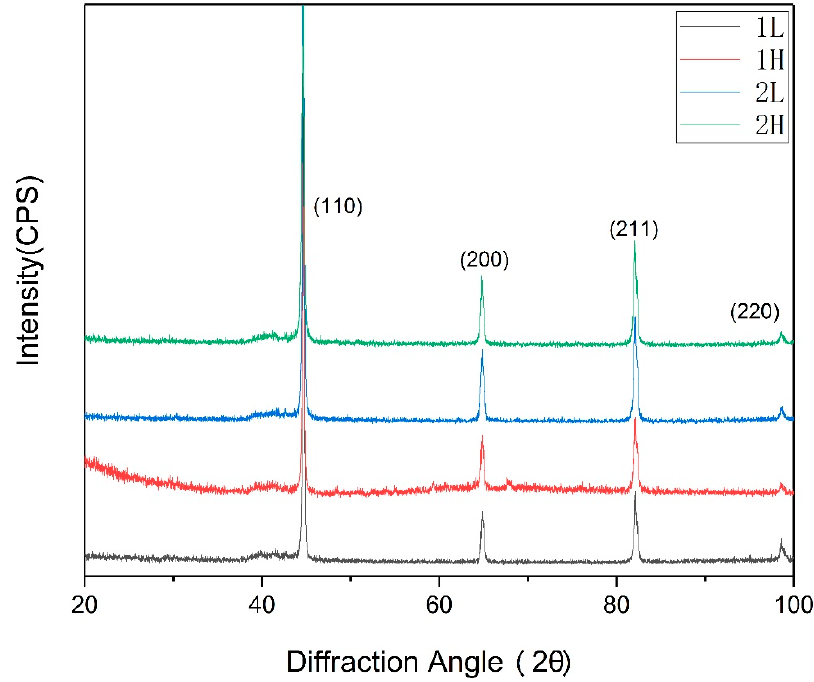
Figure 2. XRD diagram for experimental steels.